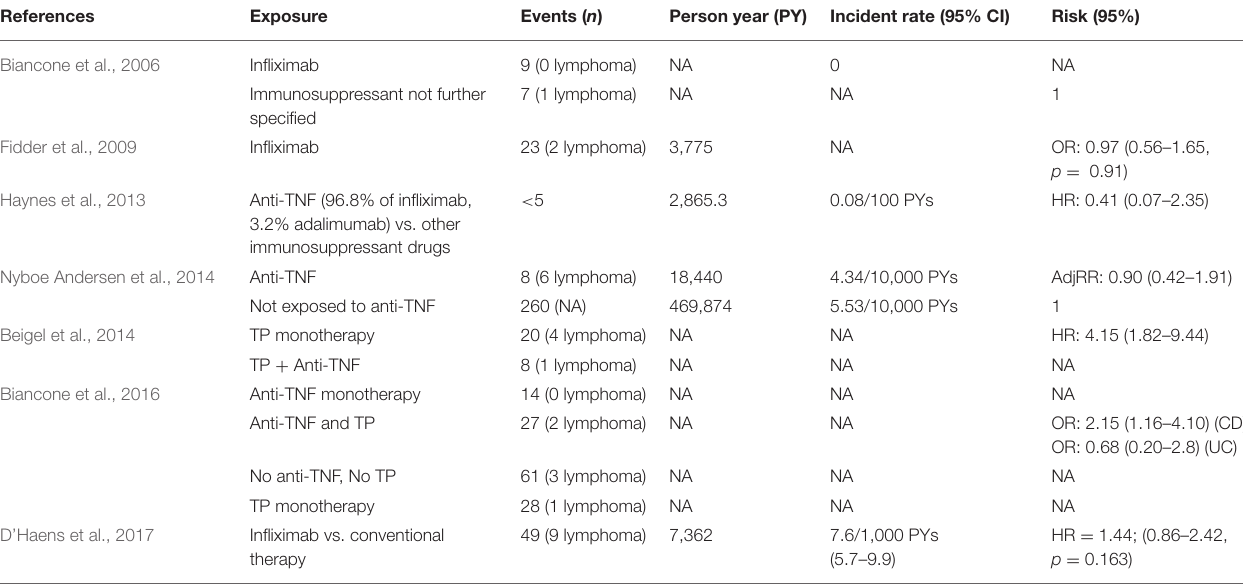
TABLE 2B | Studies with lymphoma included in a composite